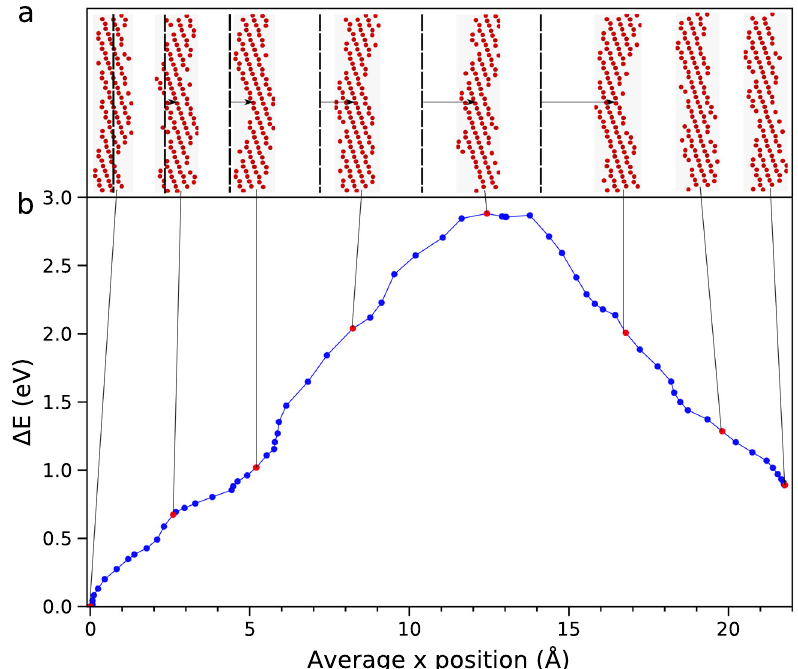
Fig. 5 Energy and shape of an edge dislocation through its minimum energy path in MoNbTaW. a Edge dislocation con fi guration at several positions along the minimum energy path, with the dashed lines indicating the original position to show the glide distance clearly. b Minimum energy path (energy versus mean dislocation position) for the dislocation moving from one minimum to the next in one region of the true random alloy.